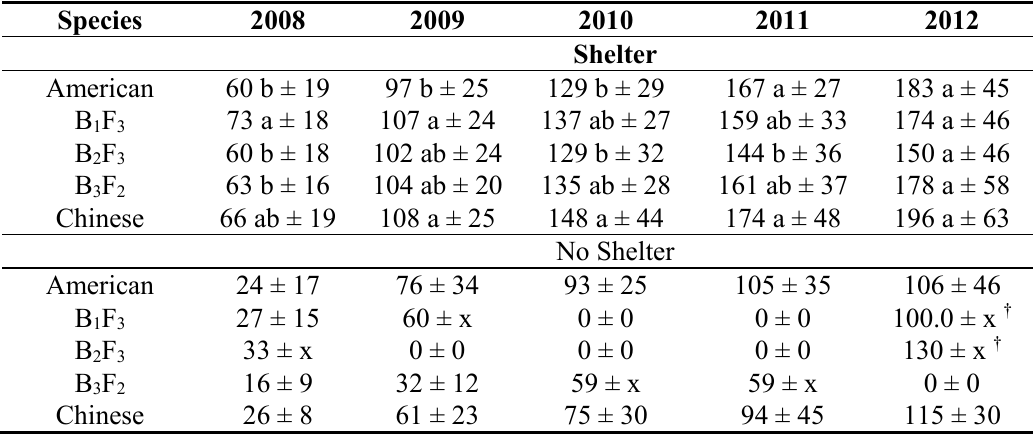
Table 3. Mean height in cm (with standard deviation) of chestnuts planted into mine soil in eastern Kentucky, compared within chestnut types and between sheltering treatments. Different letters indicate a significant shelter effect ( p < 0.05) within species. (SD of “x” indicates that sample size is too